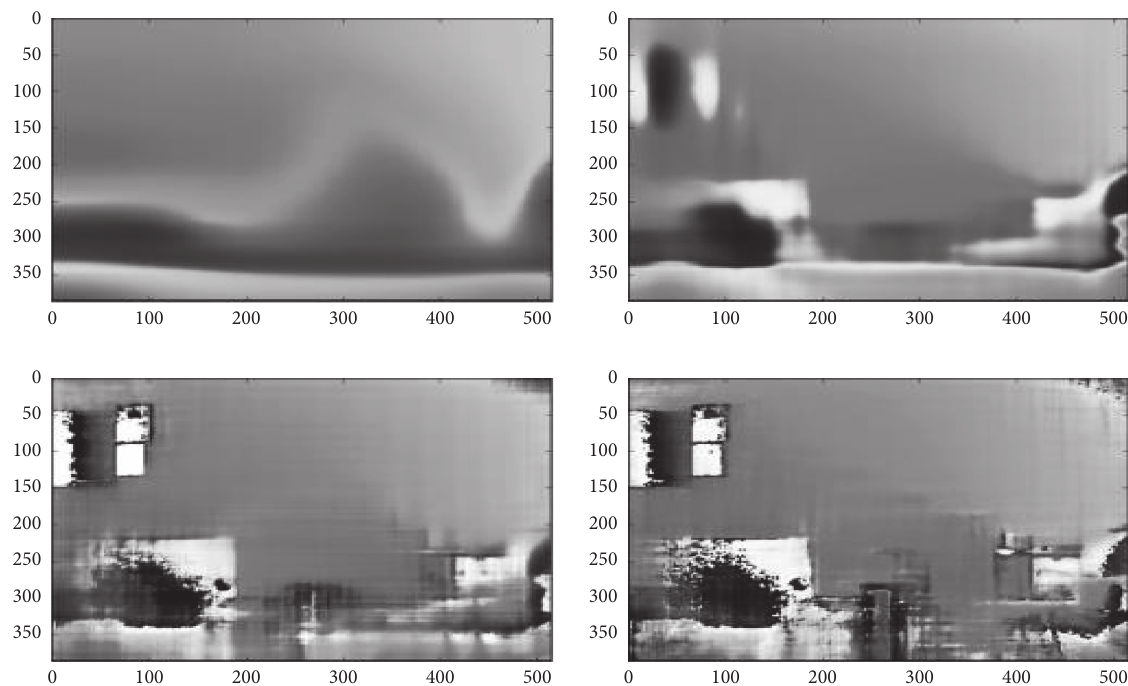
Figure 8: Depth map generated during the convolutional neural network patching process.